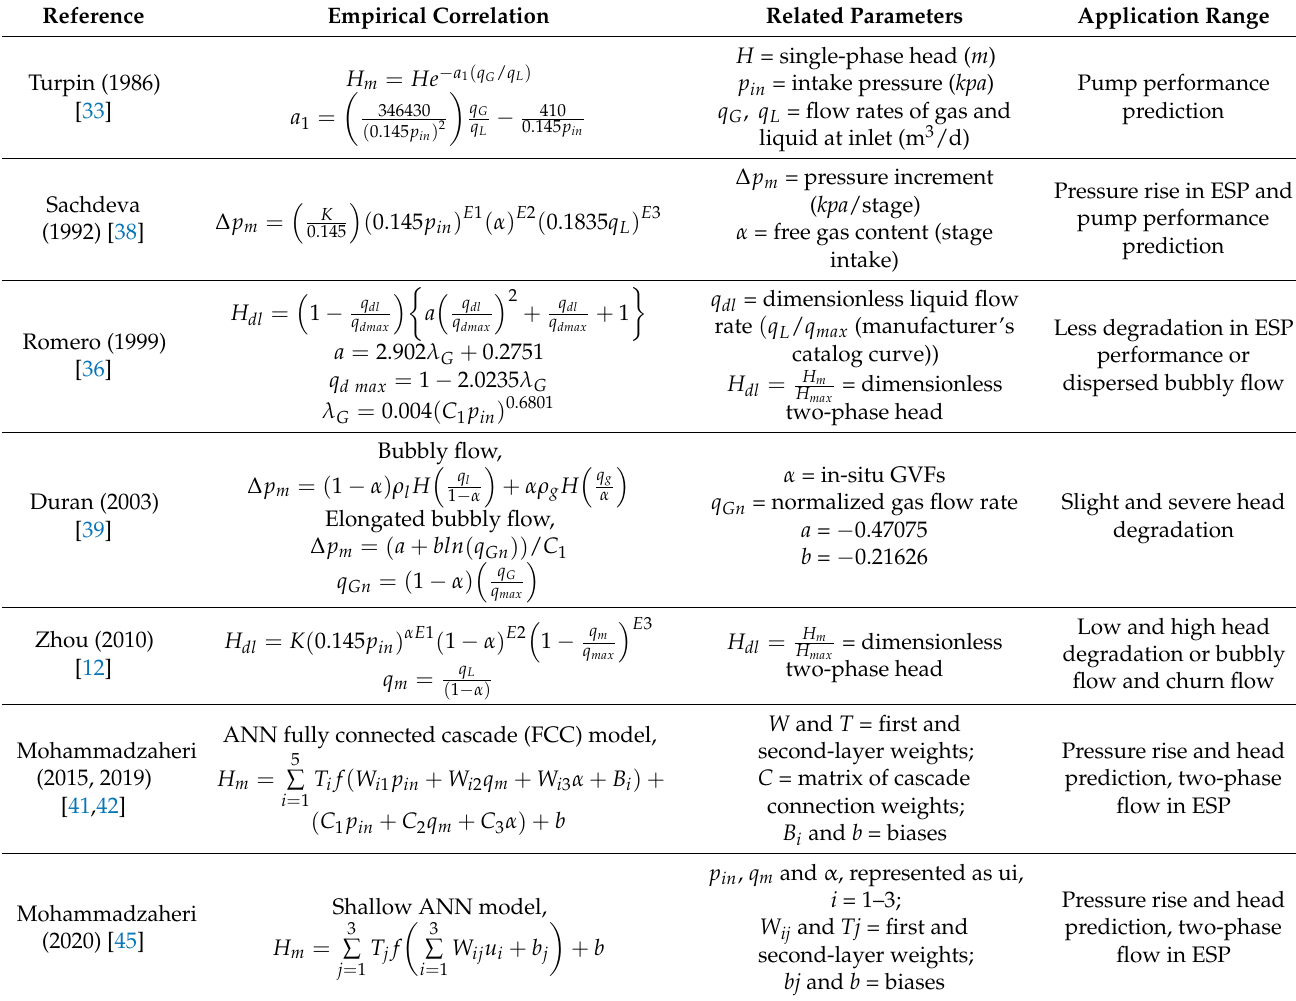
Table 2. Empirical correlations used for pump performance prediction at multi-phase flow